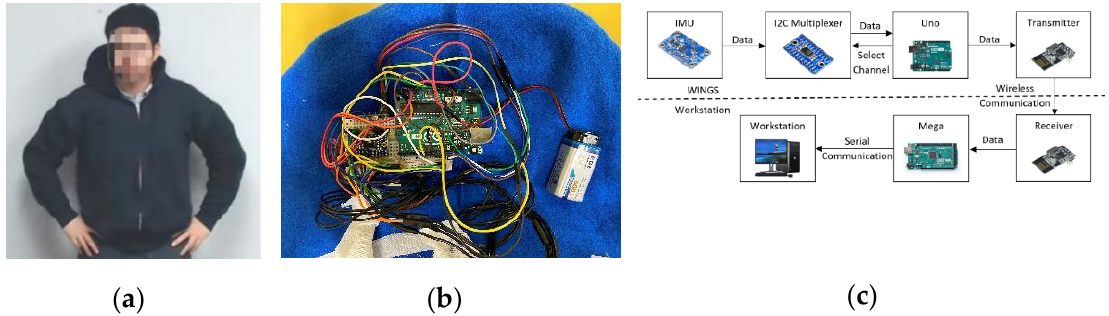
Figure 4. ( a ) Wearable Intelligent Non-invasive Gesture Sensor (WINGS) on a user; ( b ) Electronics hidden inside WINGS; and ( c ) WINGS electronic design.